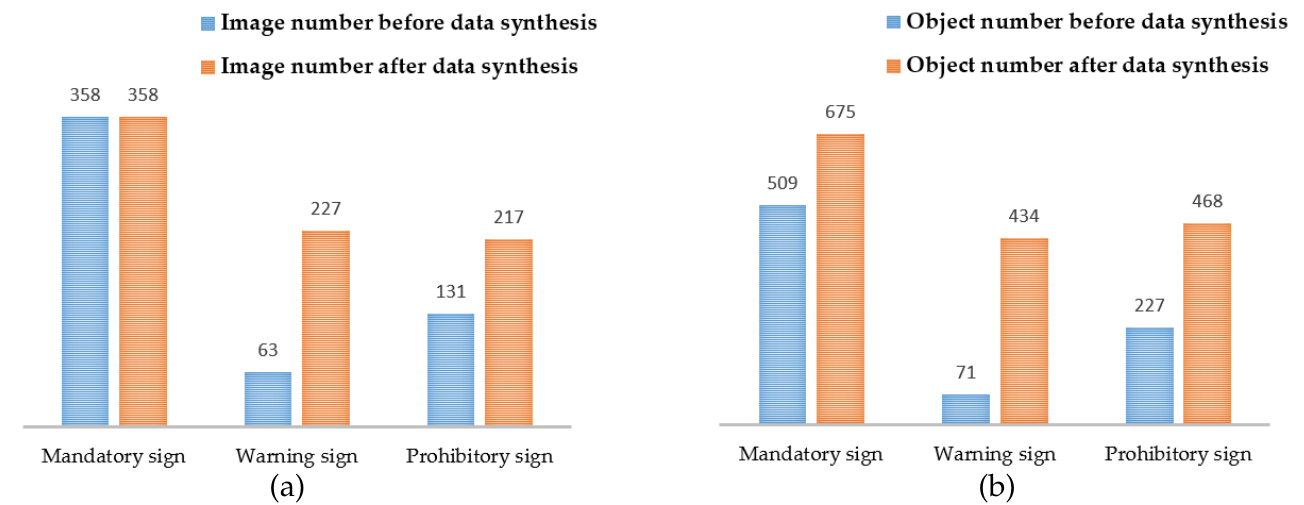
Figure 11. ( a ) The number of oblique aerial images containing each road sign category before and after data synthesis. ( b ) The number of road signs belonging to each category before and after data synthesis.